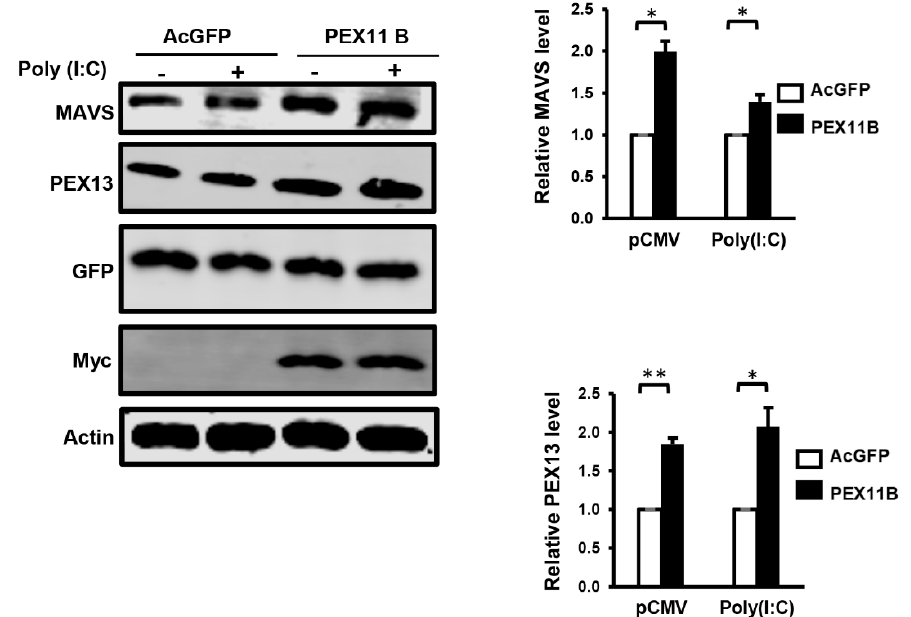
Figure 5. Over-expression of PEX11B increases the expression of MAVS protein. U251 cells were transduced with lentiviruses encoding AcGFP alone or AcGFP plus myc-tagged PEX11B for 48 h and then transfected with poly(I:C) ( + ) or an empty plasmid vector ( − ) for 12 h. The cell lysates were processed for immunoblot analyses with a mouse monoclonal antibody to MAVS, rabbit polyclonal PEX13, goat polyclonal antibody to GFP, and a mouse monoclonal antibody to the myc epitope. The relative levels of MAVS and PEX13 (compared to actin) from three independent experiments were averaged and plotted. Bars represent standard error of the mean. ** p < 0.01, * p < 0.05.